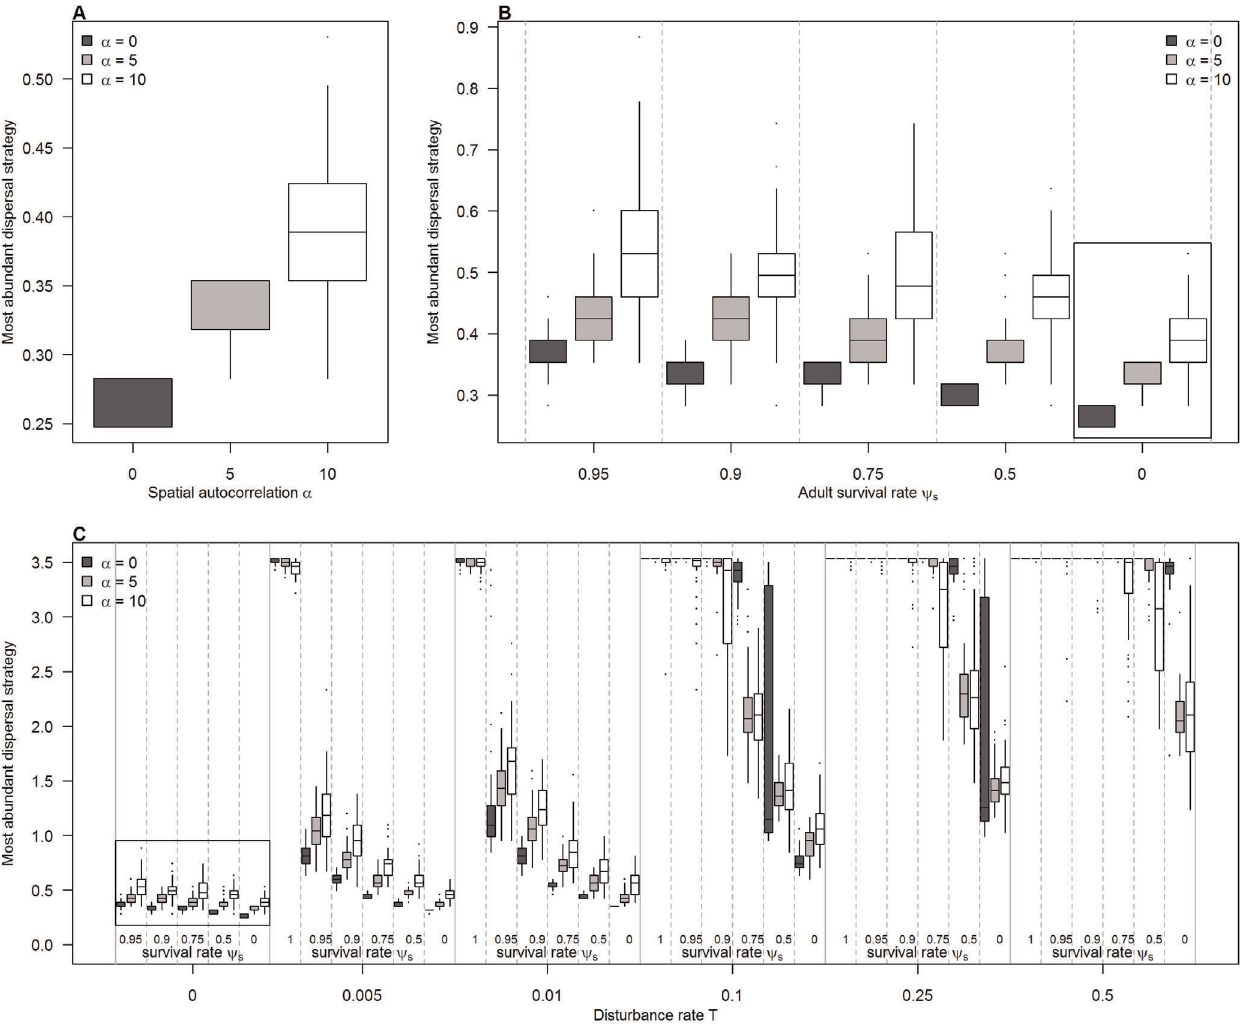
Figure 3. Dominant dispersal strategies for the generalist species ( s s =0.5). Most abundant dispersal strategy as a function of spatial autocorrelation a , adult survival rate y s , and disturbance rate T. (a) Influence of spatial autocorrelation when y s =0 and T=0. (b) Influence of spatial autocorrelation and survival rate when T=0. (c) Influence of spatial autocorrelation, adult survival and disturbance rate. Each box represents the distribution of the n=50 replicates. Results for the specialist species are presented in Figure